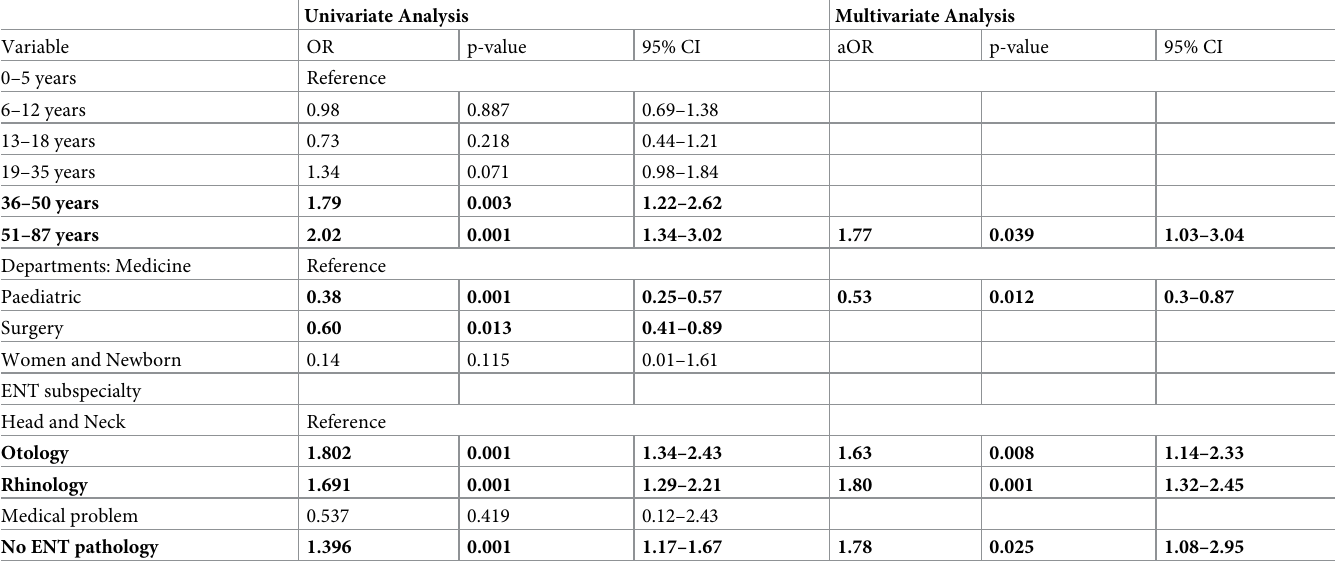
Table 2. Univariate and multivariate logistic regression of the pre-ENT referral misdiagnosis among the different patient groups.